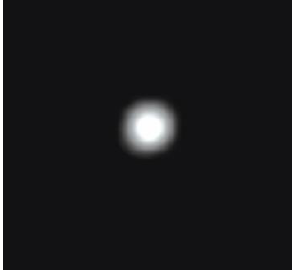
Figure 10. Images of diffuse spot collected by the COS prototype ( a ) before noise reduction, ( b ) after noise reduction.